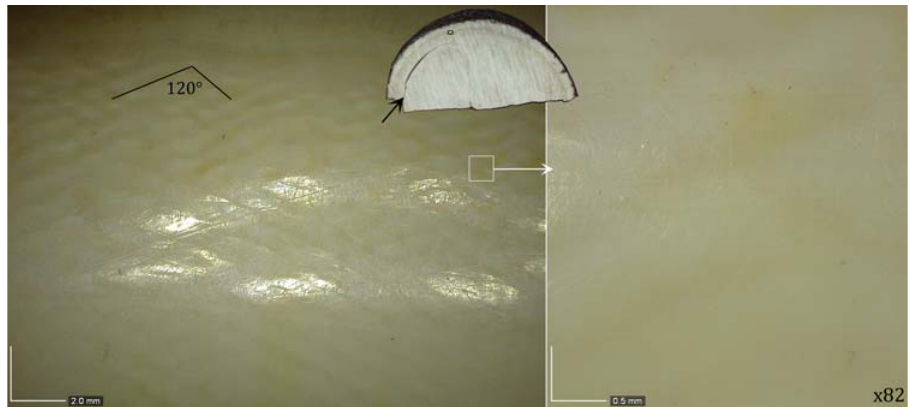
Figure 4: Cross section of a Proboscidian half - tusk ( transversally cut with a modern saw ) showing the start of a fracture - line between its dentine cones of growth ( black arrow ) and aspect ( and angle ) of the Schreger ( or cross hatching ) lines ( magni - fi cation × 20, left, and × 82, right ) typical to animal ivory ( Penniman, 1952 ) . The microscopic structures of the dentine ( dentinal tubules ) are not visible here while they grow from the central nerve cavity toward the cementum and are 0.8 to 2.2 micrometres in diameter ( Espinoza & Mann, 1992 ) ( Photo: Éva David ) .